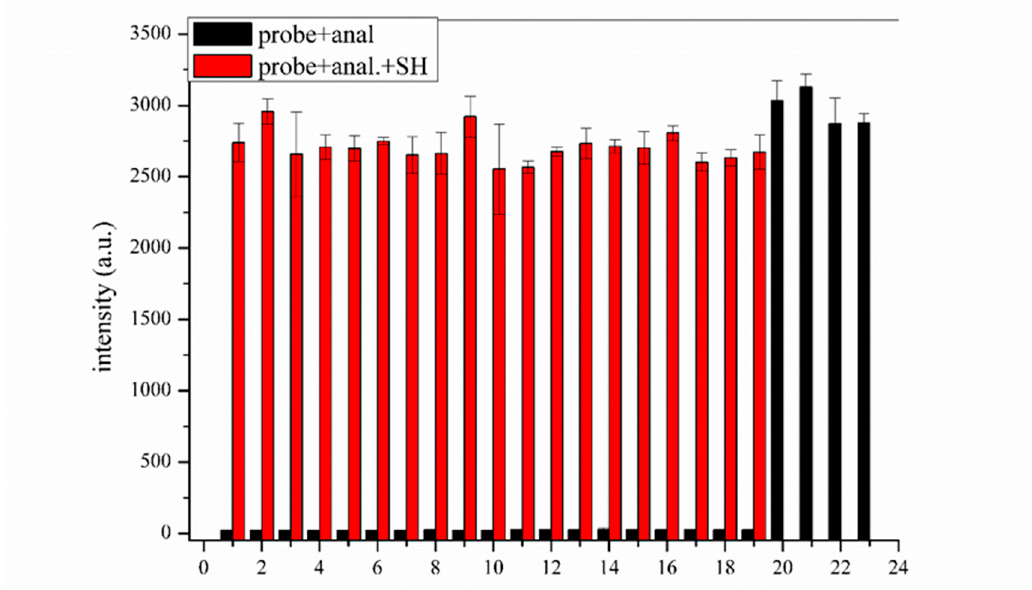
Figure 3. The fluorescence intensity at 540 nm ( λ ex = 410 nm) of probe-KCP (10 µ M) in the presence of 100 µ M of various analytes in DMSO/PBS buffer (1:1, v / v , 20 mM, pH 7.4) at 37 ◦ C prior to (black bars) and after (red bars) addition of 100 µ M 4-methoxythiophenol to the individual probe/analyte solution. (1) blank, (2) GSH,(3) Cys, (4) Hcy, (5) Ala, (6) Ser, (7) NaSH, (8) C 2 H 5 SH, (9) Ph-OH, (10) Ph-NH 2 , (11) NaCl, (12) FeCl 2 , (13) KCl, (14) CaCl 2 , (15) FeCl 3 , (16) MgSO 4 , (17) NaNO 3 , (18) KF, (19) NaHCO 3 , (20) 4-toluenethiol, (21) 4-methoxythiophenol, (22) 4-aminothiophenol, (23) 4-fluorothiophenol. Data were recorded 30 min after addition of analytes/ thiophenols with excitation at 410 nm and emission at 540 nm. Error bars are relative standard deviations (RSD), n =3.